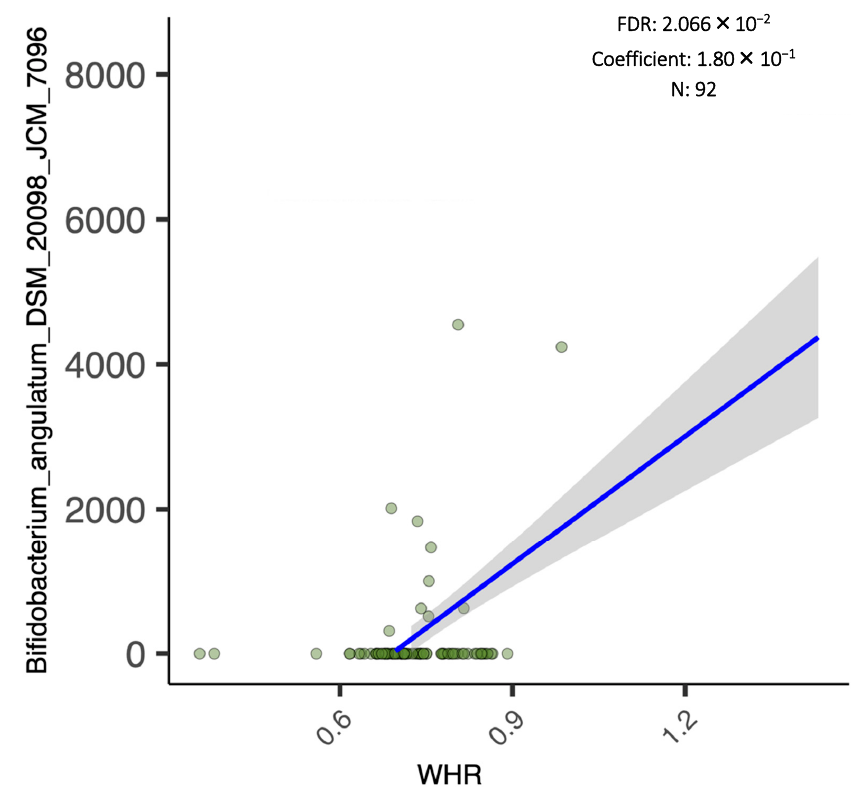
Figure 7. Linear regression analysis of Bifidobacterium angulatum DSM 20098 , JCM 7096 and WHR.